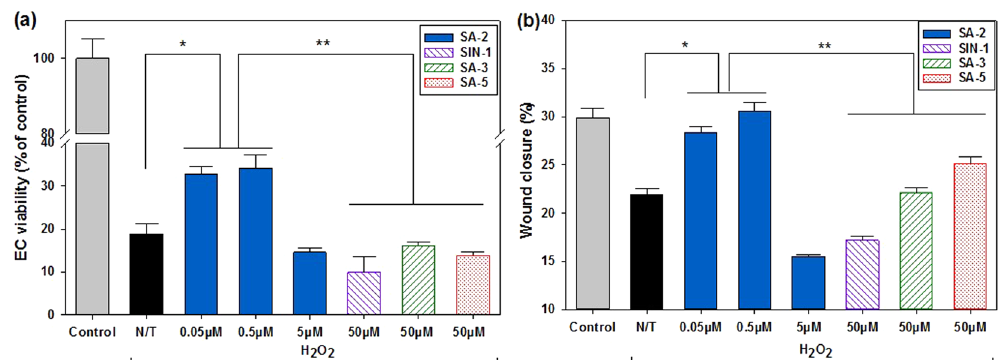
Figure 3. Effects of SA-2 on EC viability ( a ) and migration ( b ) under oxidative stress conditions. Cells were seeded and allowed to attach on tissue culture plates. For the cell migration study, micropipette tips were used to make scratch lines on wells, and images were taken for measuring distances of gaps. In all studies, cells were treated with H 2 O2, and SA-2 at different concentrations. A reference NO donor SIN-1 (50 µ M), a reference antioxidant SA-3 (50 µ M), or a reference hybrid compound SA-5 (50 µ M) was added to cell samples, incubated for 24 hours, assessed for cell viability and migration, and used for comparison. Controls were cells not exposed to H 2 O 2 or any treatment reagent. N/T samples were cells exposed to H 2 O 2 without any test compound. Cell viability was quantified with MTS assays, while cell migration was imaged and analyzed for final distances of gaps via ImageJ. Results were then processed for statistical analysis using ANOVA followed by post-hoc comparisons (SigmaPlot). Results are presented as mean values ± SEM. Stars indicate significant differences (P < 0.05; n = 5) with respect to N/T ( * ) and reference drugs ( **